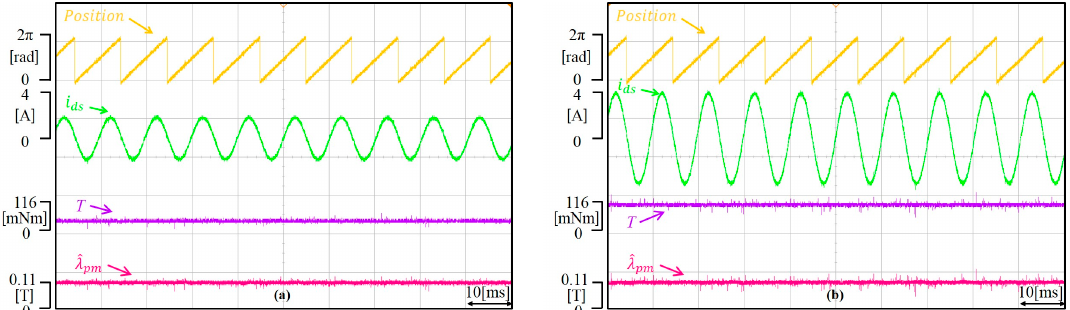
Figure 16. Steady state responses of the test SPMSM drive without applying the proposed algorithm. ( a ) Torque command: 50 mNm ( b ) Torque command: 127 mNm (Operating condition: ω r = 620 rad/s, permanent magnet temperature = 100 °C).